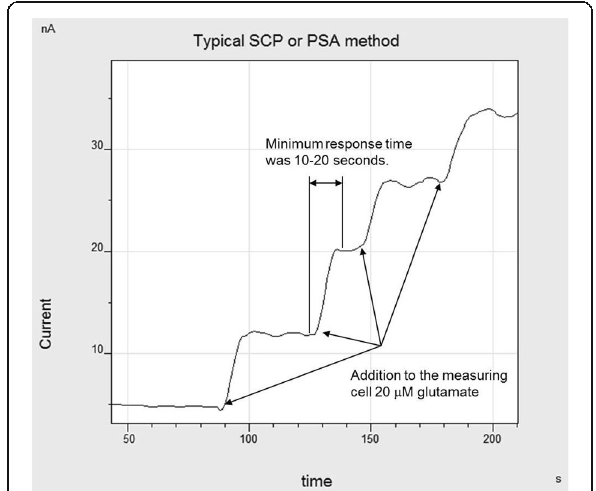
Fig. 7 Typical responses of biosensor, based on GlOx adsorbed on silicalite, to 20 μ M glutamate. Measurements in 20 mM HEPES buffer,